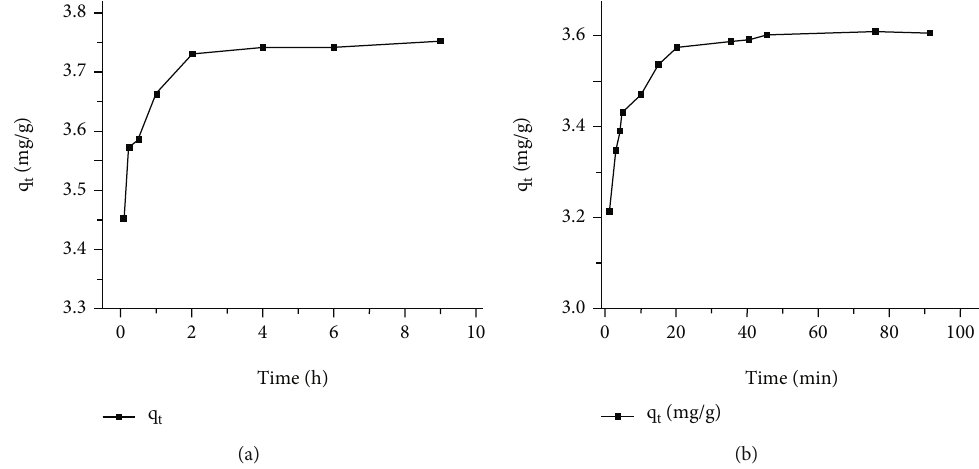
Figure 4: E ff ect of agitation time on MB removal (a) BB and (b) EVML (conditions: initial concentration (10 mg/L), adsorbent dose (2.5 g/ L), shaking speed 200rpm, and temperature 25 ± 1 ° C